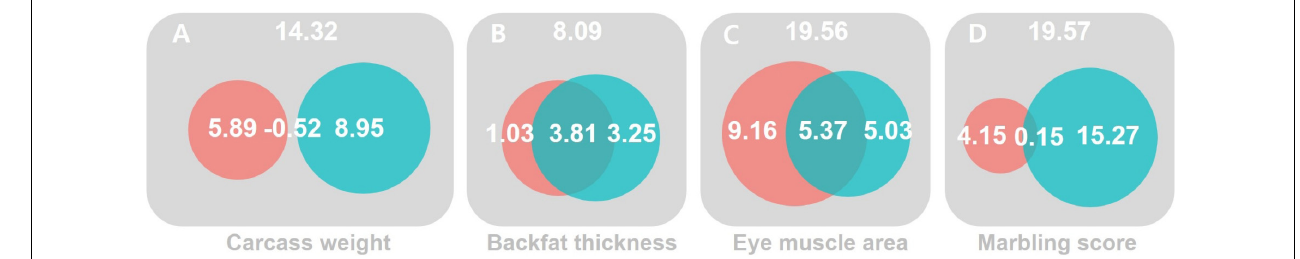
FIGURE 1 | The magnitude of significance for G × E THI and R × E THI interactions and their collinearity. MRNM was used. The magnitude of significance for the combined G × E THI (red) and R × E THI (blue) interaction effects was calculated by log-likelihood comparison between the full and null models for four carcass trait; carcass weight (A) , back fat thickness (B) , eye muscle area (C) and marbling score (D) (see Supplementary Table 6 ). The intersection between the G × E THI (red) and R × E THI (blue) interaction effects indicates a dependency due to the collinearity between the two interaction effects. The magnitude of dependency (the intersection) between G × E THI and R × E THI interactions is the difference between the magnitude of combined G × E and R × E interactions and the sum of the magnitudes of orthogonal G × E and R × E interactions (see Methods and Supplementary Table 6